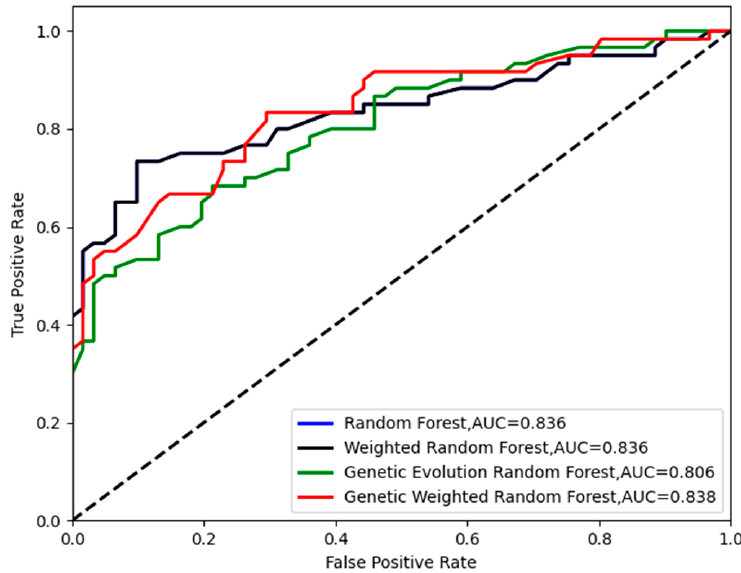
Figure 5. The ROC curves of the four models in S valid .